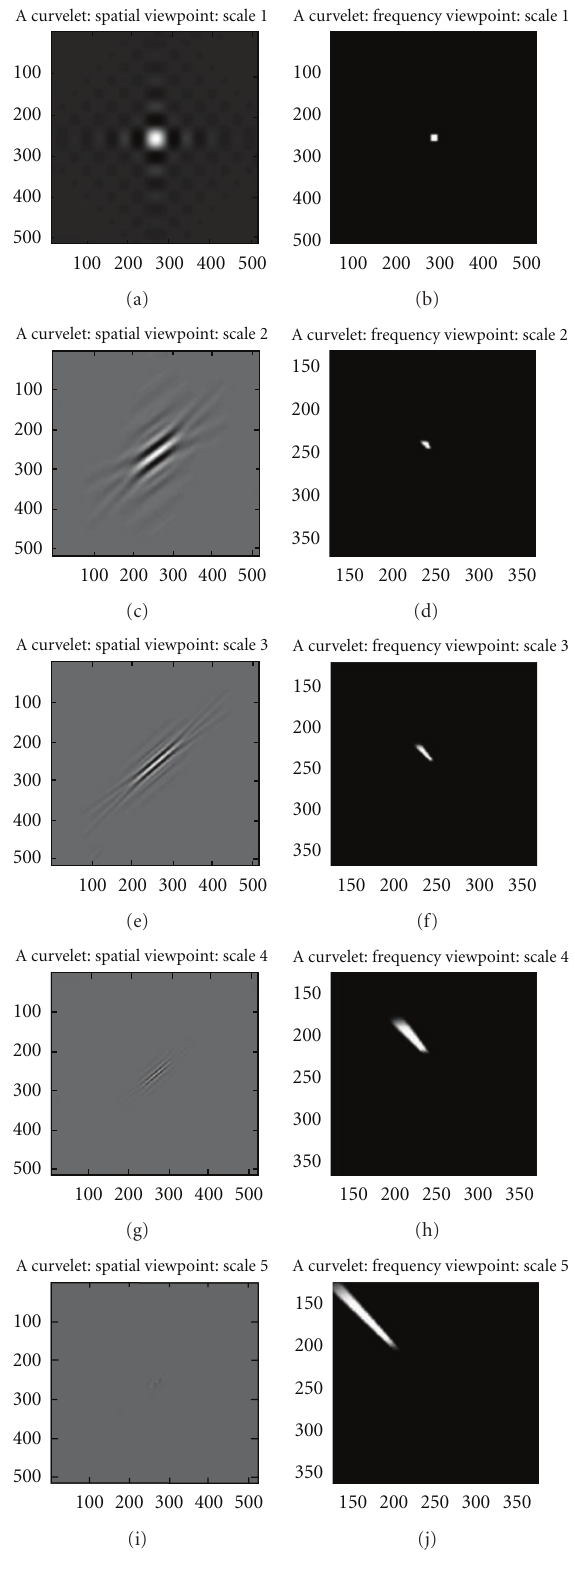
Figure 11: Curvelets at increasingly fine scales from 1 to 5. Spatial domain (a, c, e, g, i). Frequency domain (b, d, f, h, j)